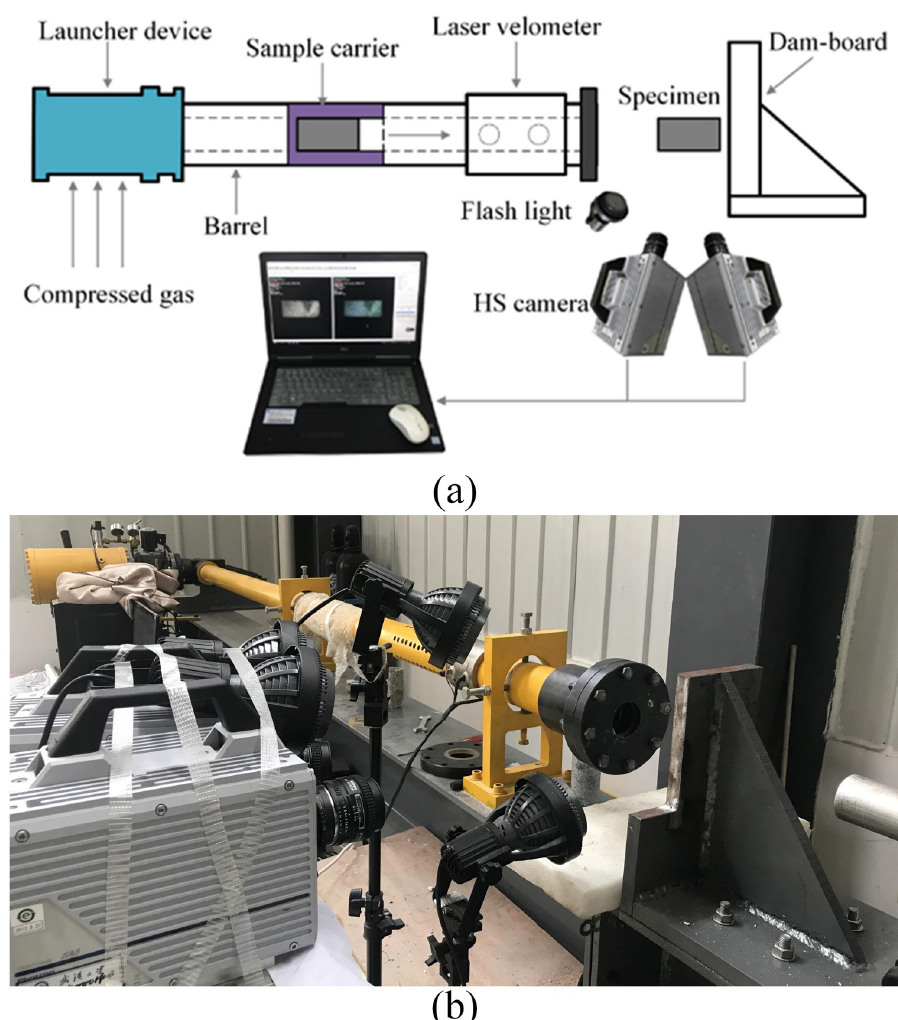
Fig 1. The compressed gas-driven impact system. (a) schematic diagram; (b) test